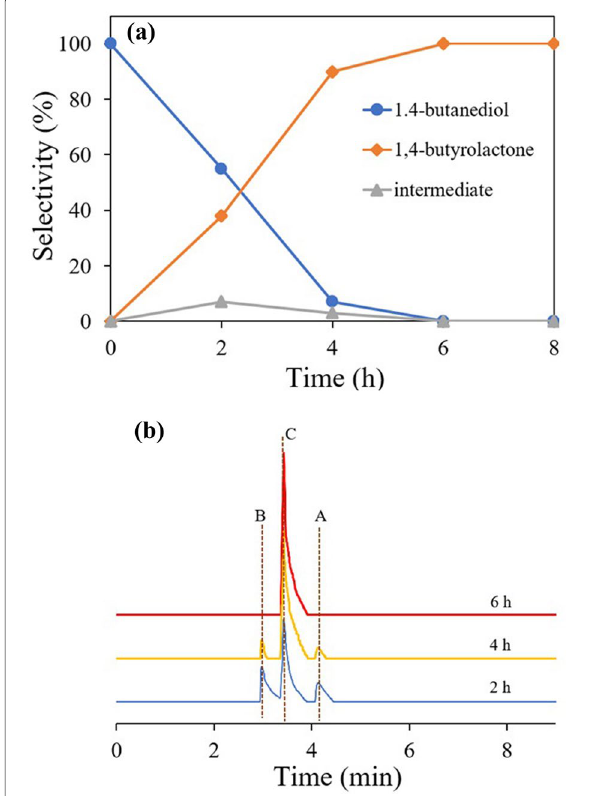
Fig. 2 HLADH– SBFC -catalyzed oxidative lactonization of 1,4-BD. a Time-selectivity plots of HLADH-catalyzed oxidation of 1,4-BD. 1,4-BD (20 mM), NAD + (0.5 mM), SBFC (0.1 mM), HLADH (0.3 g L − 1 ), and catalase (20 U/mL) in 1 mL of aqueous Tris–HCl buffer (50mM, pH 8.0) at 30 °C. b The results of reactions after 2 h, 4 h and 6 h detected by GC–MS. Peak A: 1,4-BD; Peak B: lactol; Peak C: